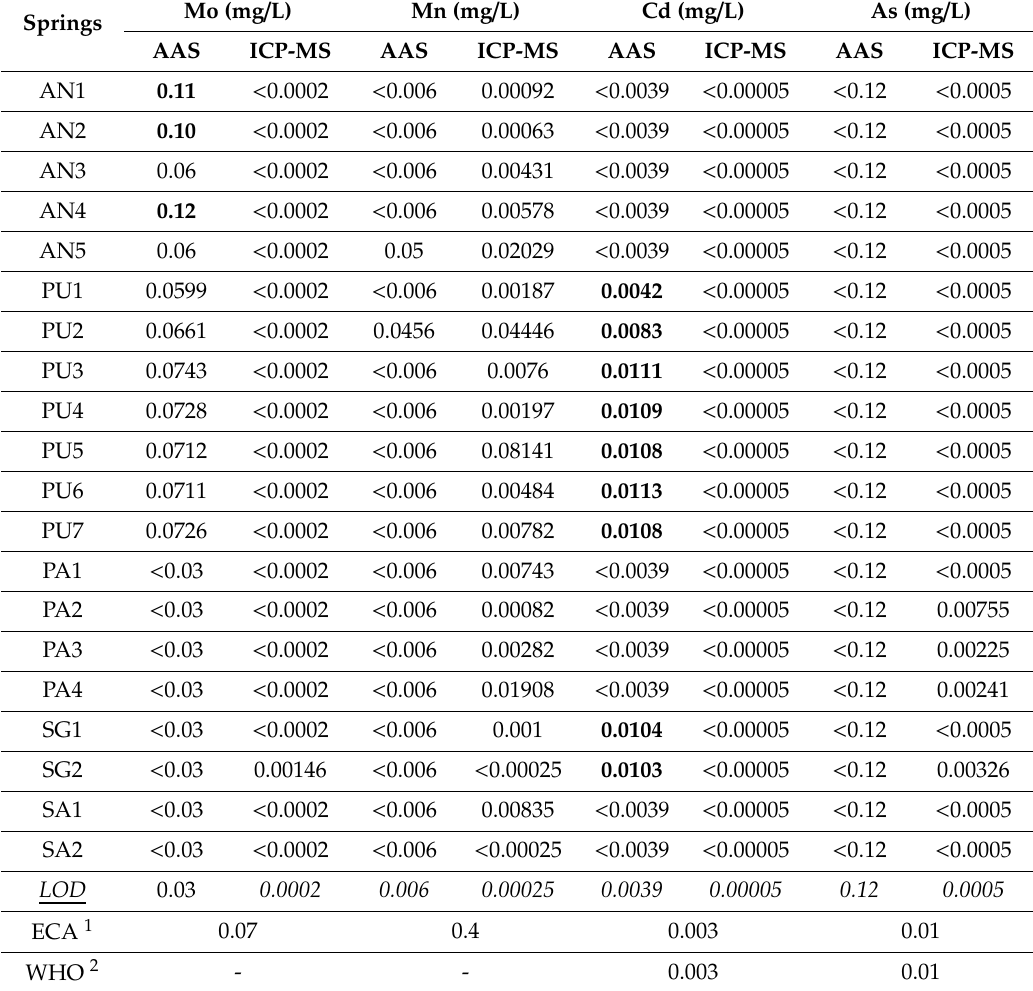
Table 4. Results of the analysis of Mo, Mn, Cd, and As using two di ff erent techniques (AAS and